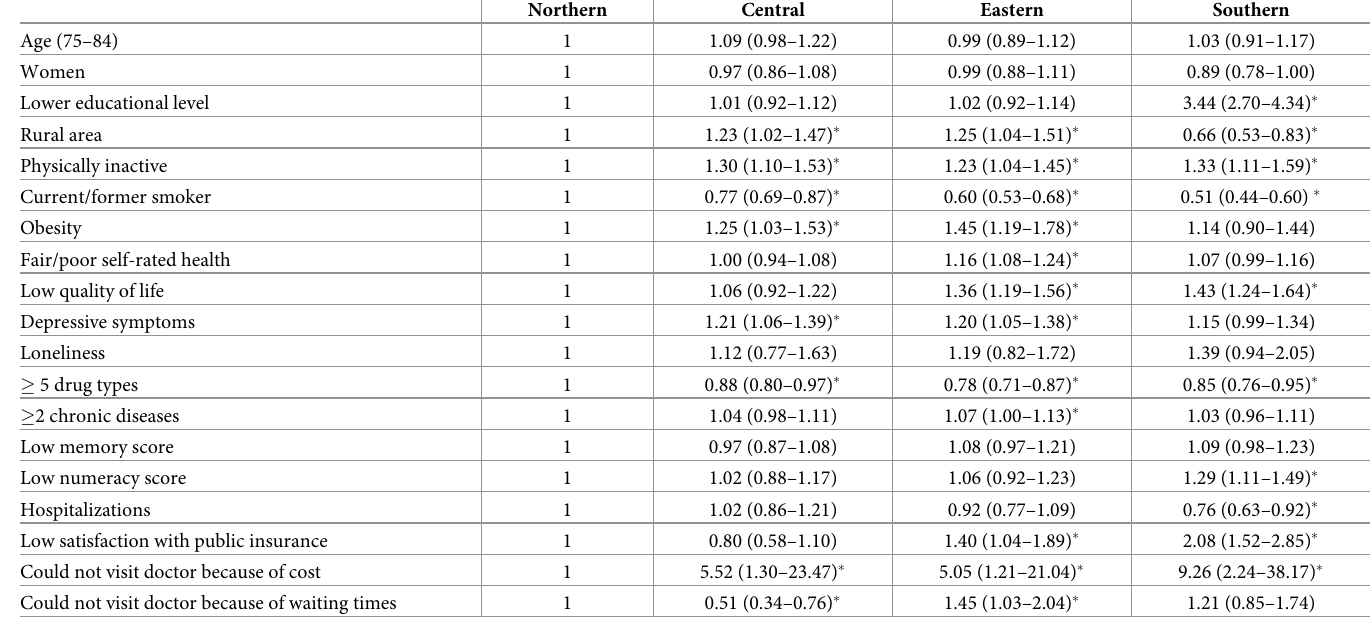
Table 4. Multivariate Poisson analysis (indicating prevalence ratios) of disabled older adults in Europe aged 65–84 (n = 4,617), according to European regions and independent variables in